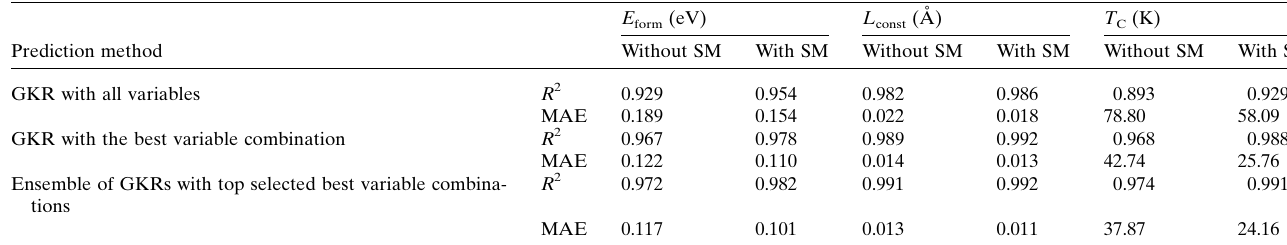
Table 2 PA values for the E form , L const and T C prediction problems. The results obtained with and without using the similarity measure (SM) information are shown for comparison.